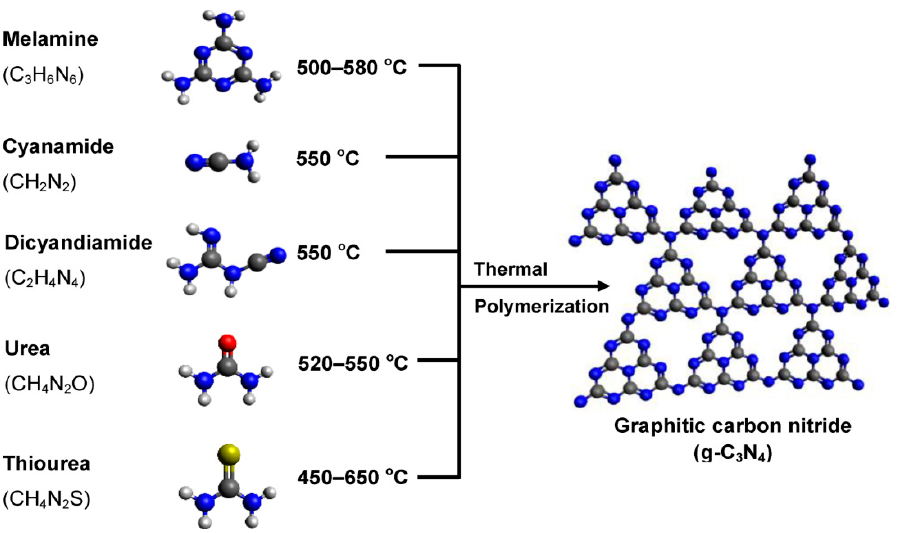
Figure 1. Schematic illustration of the synthesis process from the possible precursors of g-C 3 N 4 . Reproduced with permission from [26]; copyright (2016), the American Chemical Society.